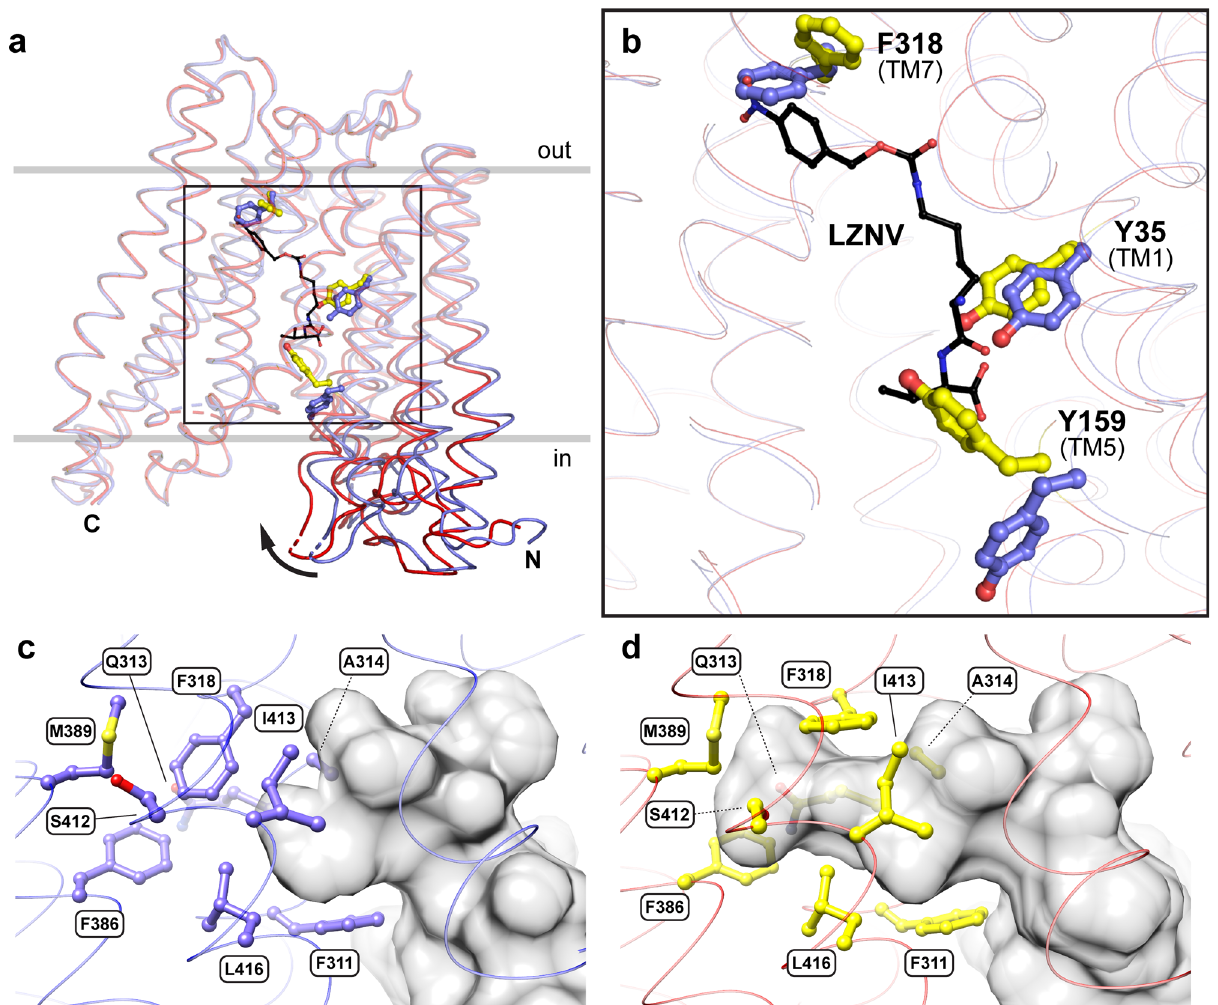
Fig. 6 Conformational changes of YePEPT K314A and formation of the PZ pocket upon binding of LZNV. a Structural alignment of overall structures of the apo (blue ribbon) and the LZNV bound YePEPT K314A (red ribbon). The location of largest displacement between the apo and LZNV bound structures is found in the N-terminal six-helix bundle facing the cytosol (in), as indicated by an arrow. b The LZNV binding site, marked in ( a ) by a black box, is displayed enlarged. Side chains undergoing signi fi cant conformational changes upon LZNV binding are depicted as sticks and coloured in blue (apo structure) and yellow (LZNV bound structure). The LZNV molecule is displayed in a smaller stick-diameter mode compared to the side chain moieties and coloured in black. Amino acids are labelled in the one-letter code and corresponding TMs are indicated in brackets. View into the PZ pocket location in the apo ( c ) and LZNV bound structures ( d ). Side chains from residues forming the PZ pocket are labelled and coloured as in b . Solvent accessible volume is displayed and coloured in grey ( c , d